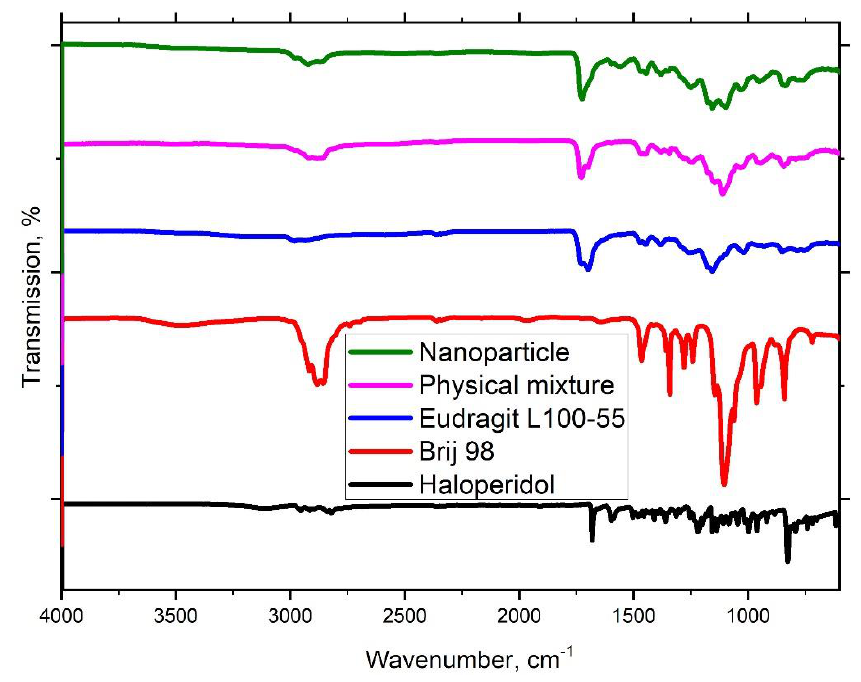
Figure 7. IR spectra of copolymer L100-55, Brij 98, haloperidol, their physical mixture and hybrid nanoparticles.